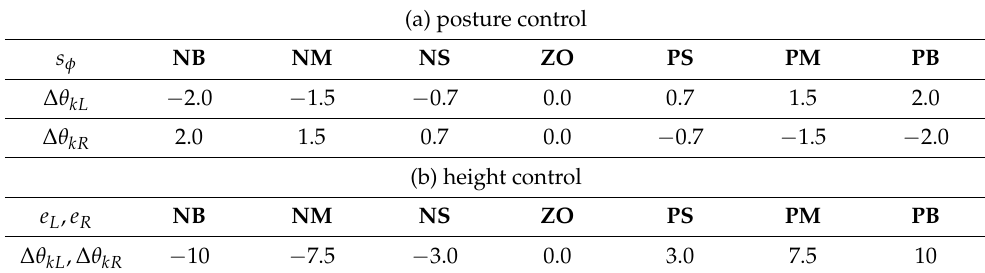
Table 3. The fuzzy rules for the FRBC.